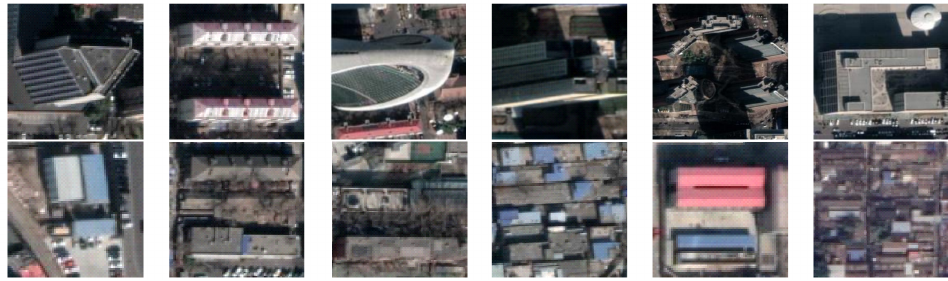
Figure 4. Examples of buildings with various shapes, types, and forms in the study area. As for datasets, versions of remotely sensed images of several resolutions are retrieved from Google Earth for the year 2018, including resolutions of 0.5 m, 1.0 m, 2.0 m, and 4.0 m, which are used as given material with scale ratio of 1, 2, 4, and 8 for each experimental case. For the training period in stage one, training and evaluation material were generated via segmenting the input images into patches of size 128 × 128 pixels. For the training period in the segmentation stage, images were cropped into 1024 × 1024 pixel patches. We extract a total of 36,000 group images with the size of 1024 × 1024 as our datasets. The datasets were further divided into training set, test dataset, and validation set according to 7:2:1